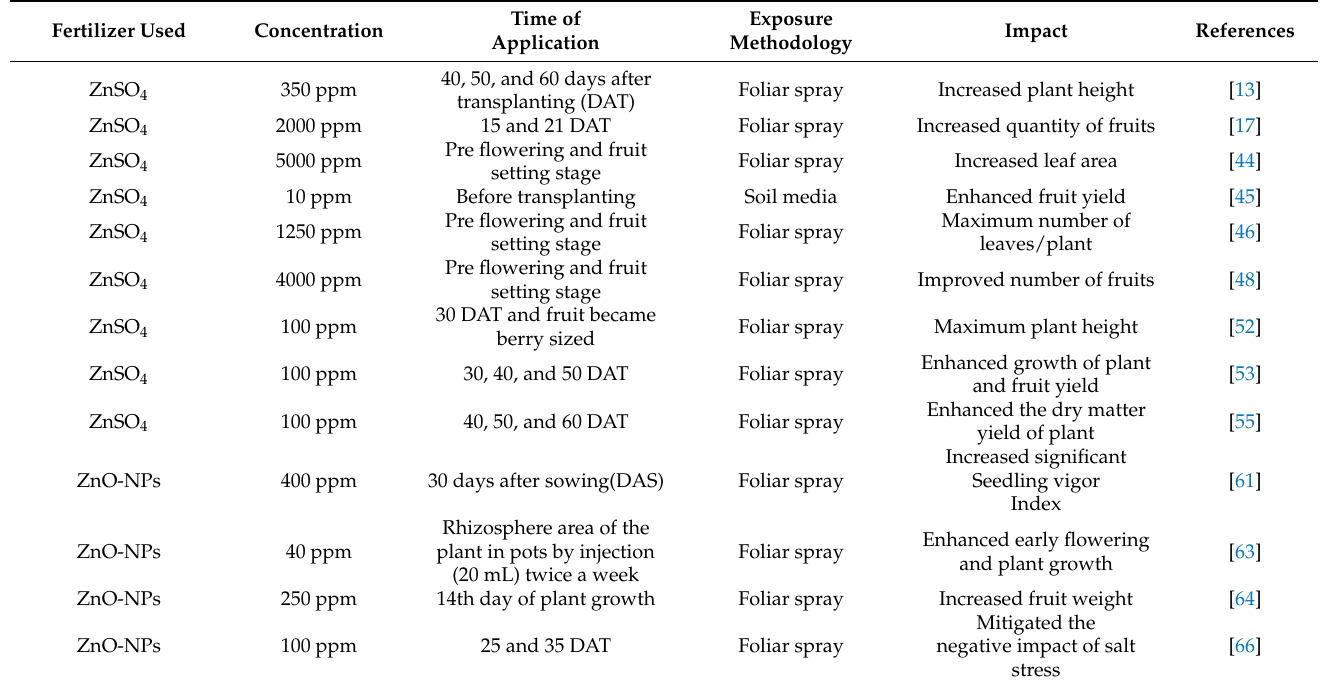
Table 3. Impact of fertilizers on tomato